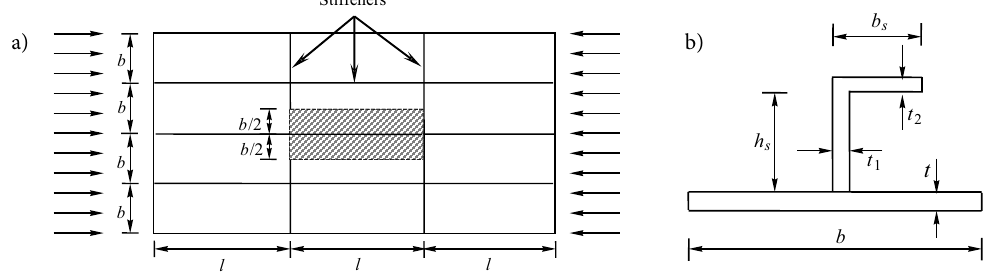
Fig. A. Stiffener cross-section: (a) Stiffened panel; (b) Longitudinal stiffener section with effective plating (Paik, Thayamballi